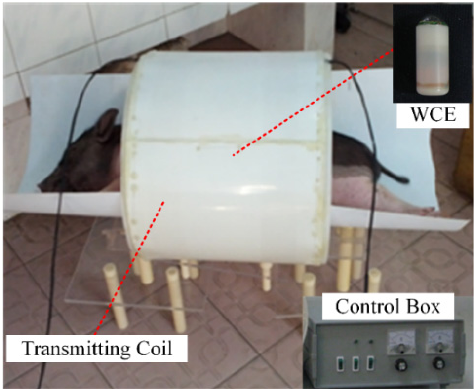
Figure 7. The setup for imaging the GI tract of live pigs with capsule endoscope.